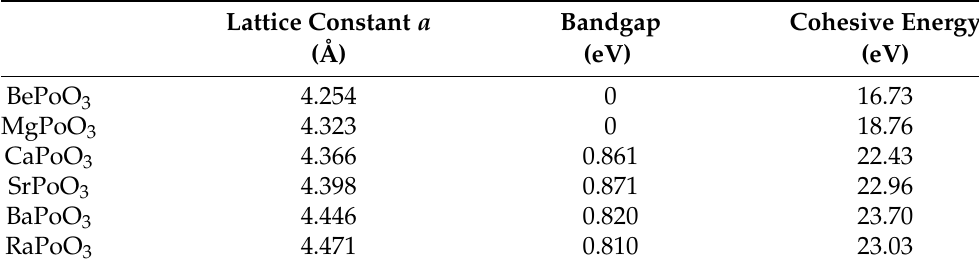
Table 1. Calculated equilibrium lattice constant a , fully relativistic bandgap and cohesive energy for APoO 3